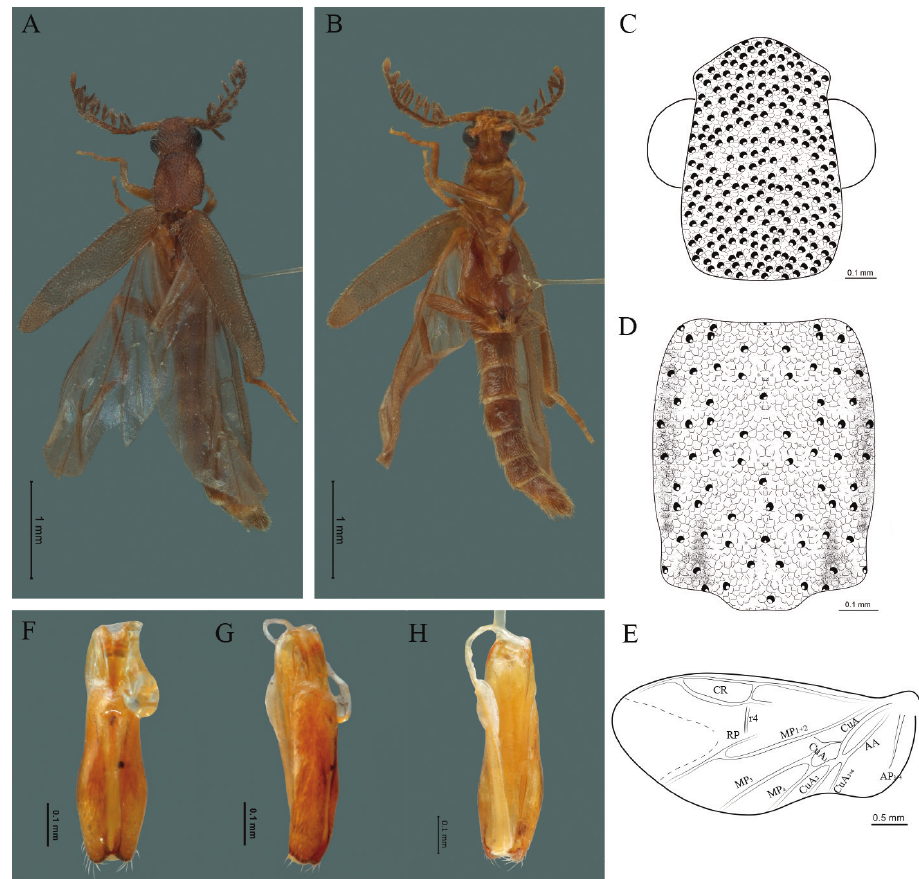
Figure 5. Cenophengus brunneus Wittmer, 1976, male. Habitus: A dorsal B ventral C head dorsal D pronotum dorsal E hind wing. Wing venation: CR = Radial Cell; r3 = radial 3 vein; r4 = radial 4 vein; RP = Posterior Radial vein; MP1+2 = Posterior Median vein; CuA = Cubital vein; AA and AP = Anterior and Posterior Anal veins. Aedeagus: F dorsal view G lateral view H ventral